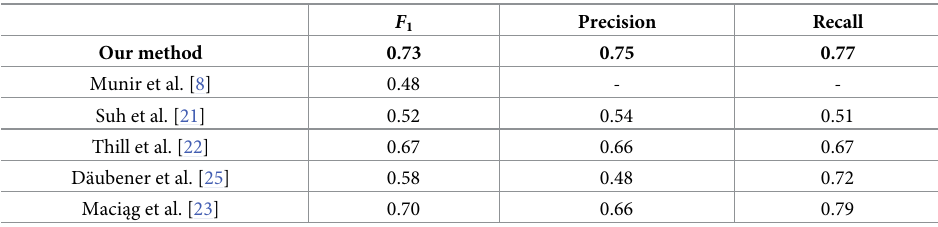
Table 1. Performance on Yahoo A1